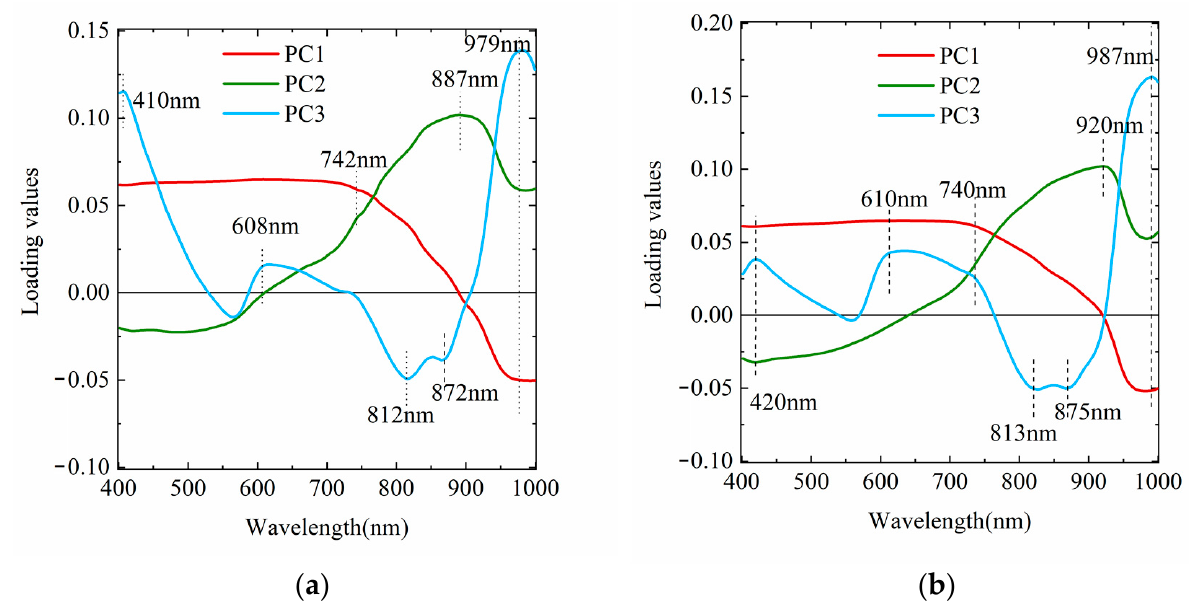
Figure 5. Loading plots of PC1, PC2, and PC3. MAM inoculated ( a ) NRRL 3357 with concentration of 10 2 spores mL − 1 ; ( b ) NRRL 3357 with concentration of 10 4 spores mL − 1 .